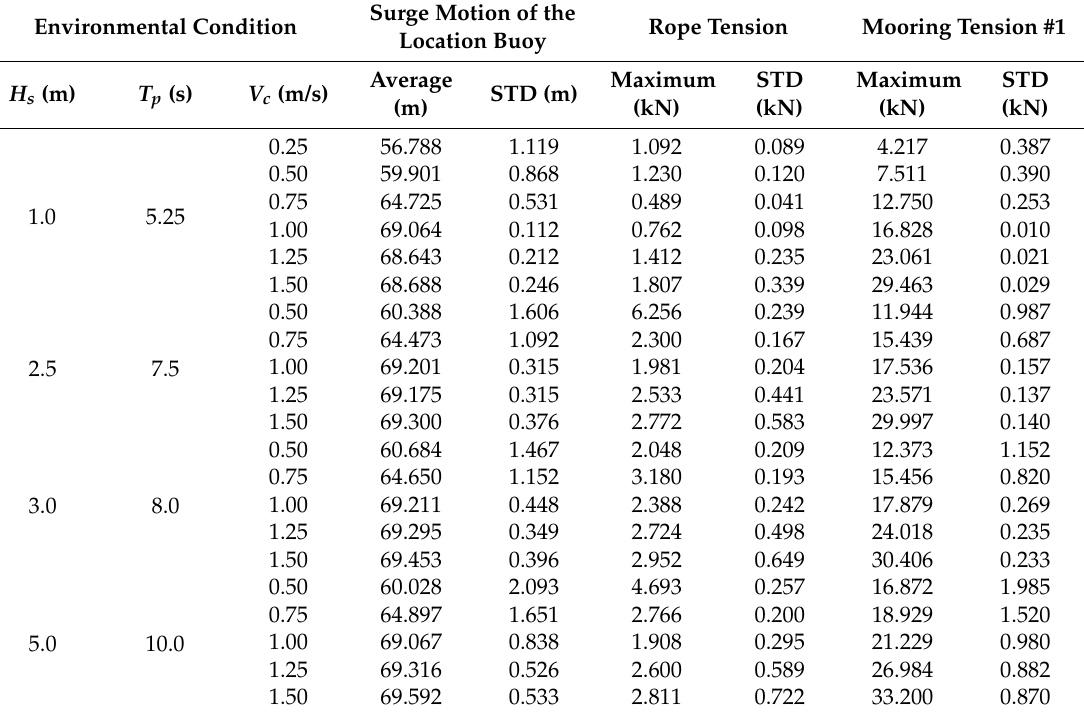
Table 4. Statistical results of surge motion of the location buoy, rope tension, and mooring tension for all simulated